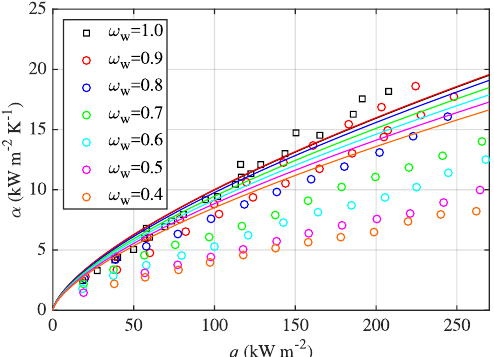
Figure 9. Measured data compared with the correlation of Stephan and Abdelsalam (solid lines).